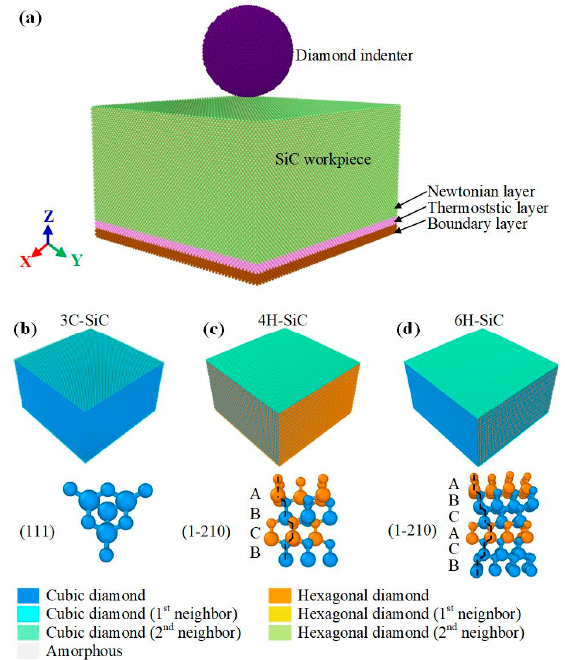
Figure 1. ( a ) MD simulation model of nanoindentation for three types of SiC single crystal: ( b ) 3C-SiC, ( c ) 4H-SiC, and ( d ) 6H-SiC, respectively. Table 1. Main parameters of the simulation models. Parameters Value Dimensions of specimens